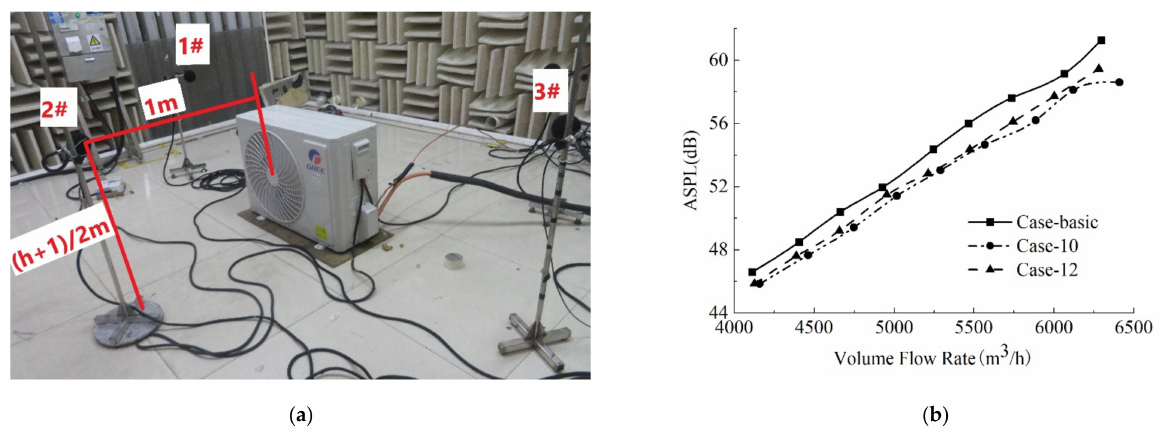
Figure 16. Noise test site and test data: ( a ) noise test site and ( b ) volumetric flow rate–noise.